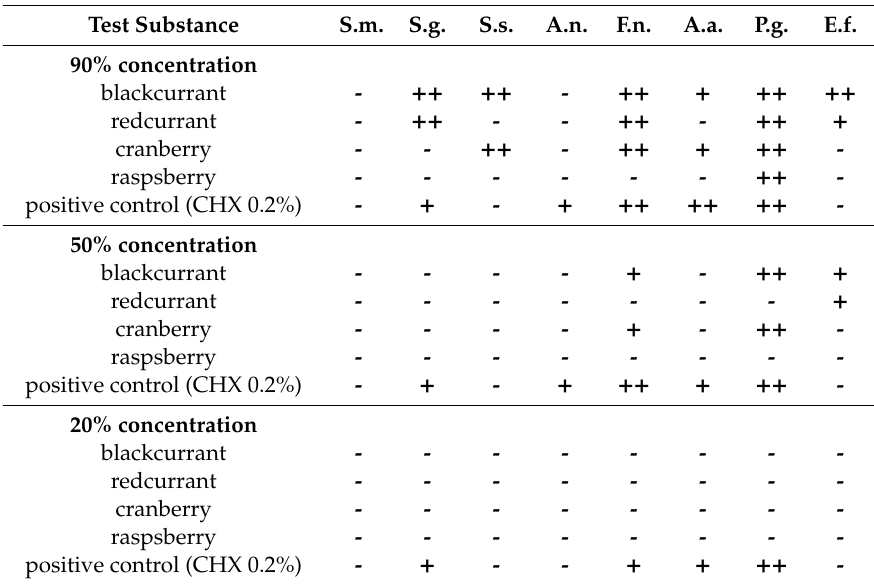
Table 1. Direct contact test—concentration-dependent antibacterial activity of berry juice (20%, 50%, 90%; exposure time 60 s) on various oral pathogenic bacterial species; no inhibitory e ff ects (-); plate counts di ff er by > 10 3 compared to untreated control ( + ); complete bacterial suppression ( ++ ). ( Streptococcus mutans -S.m.; Streptococcus gordonii -S.g.; Streptococcus sobrinus